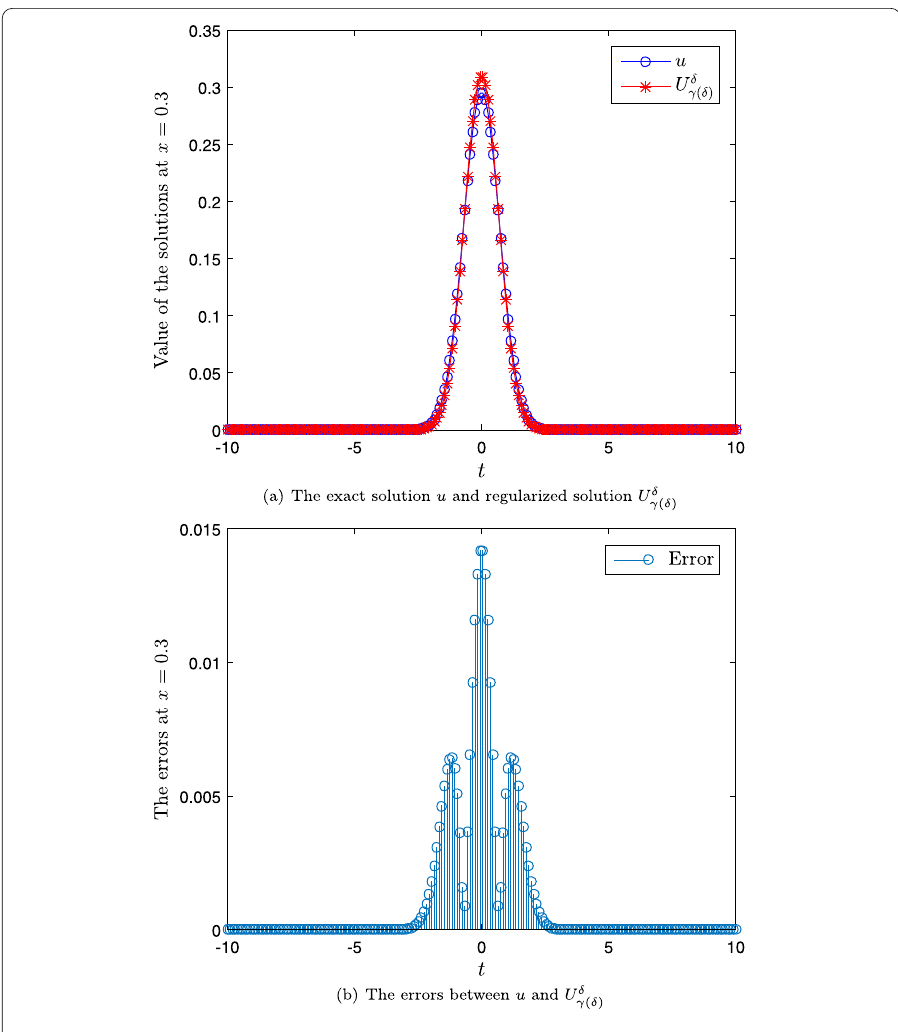
Figure 3 The solutions and errors at δ = 0.0001 with ( x , t ) ∈ { 0.3 } × (–10,10)